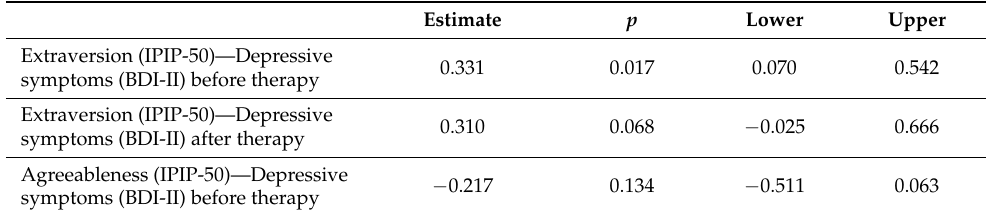
Table 4. Standardized regression weights for associations between personality and depressive symptoms before and after therapy in the investigated group.